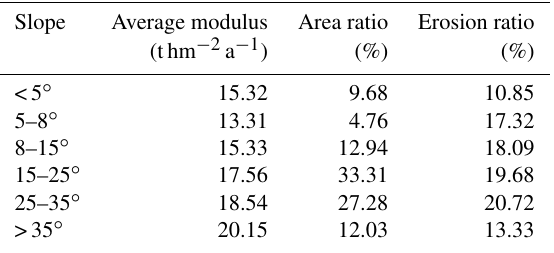
Table 4. Soil erosion conditions on different slope grades. Slope Average modulus Area ratio Erosion